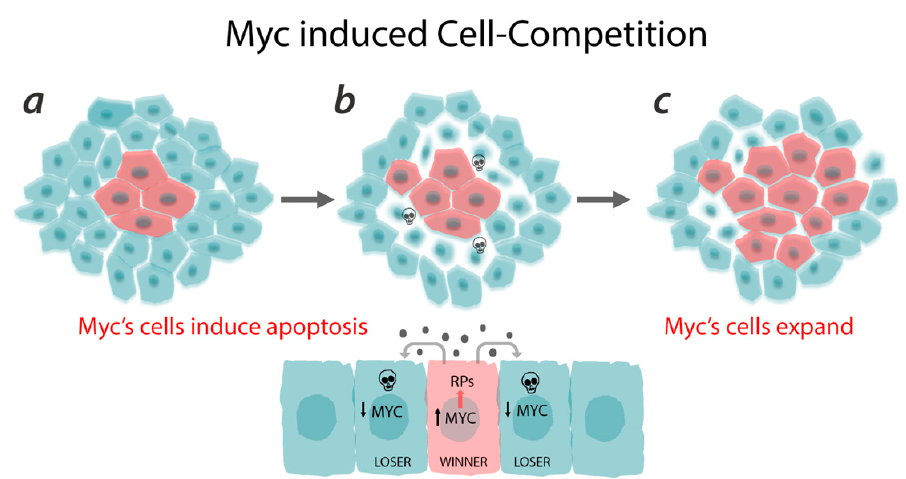
Figure 4. Schematic representation of Myc-induced cell competition. Myc cells are better fitted ( a ) and grow at the expenses of wild type cells that die of apoptosis ( b ) allowing Myc-expressing cells to grow and invade the field ( c ). In particular, here we focused on the ability of Myc-expressing cells (winner)